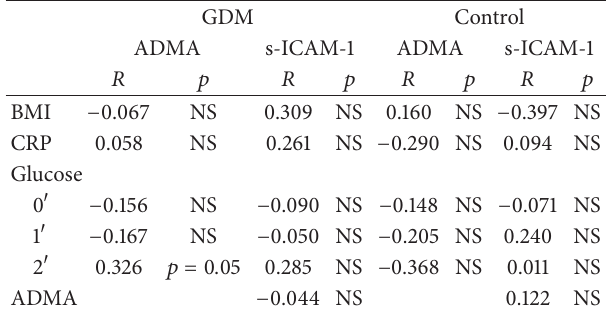
Table 3: Correlation between ADMA and s-ICAM-1 levels and BMI and CRP levels and glucose levels in OGTT in patients with GDM and control